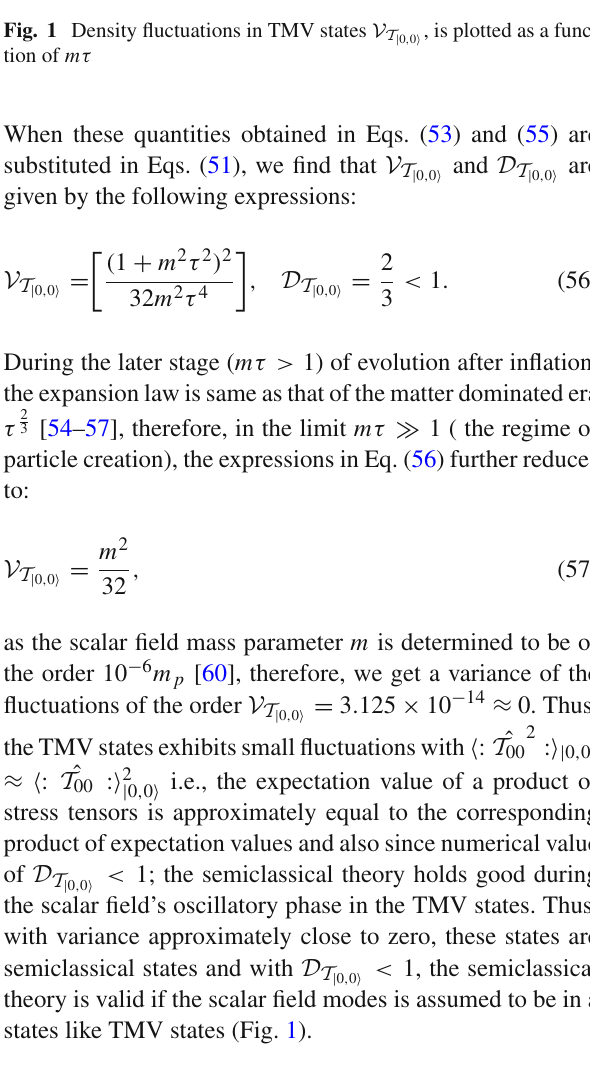
, is plotted as a func- 0 , 0 (cid:3)